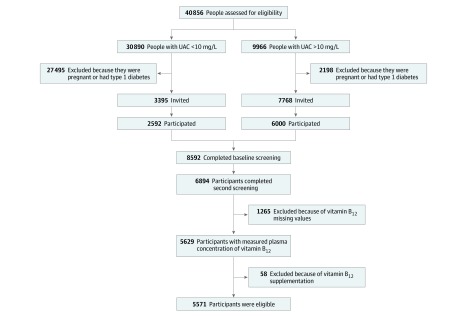
Cohort Recruitment FlowchartUAC indicates urinary albumin concentration.